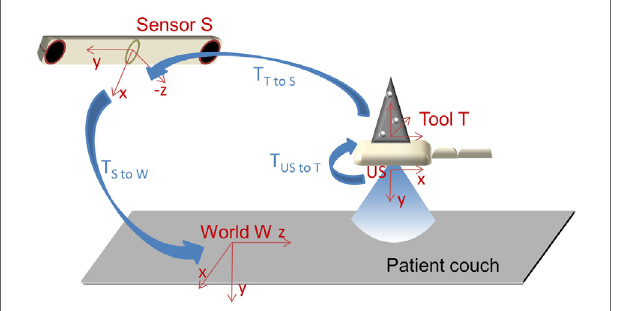
FigUre 1 | The four involved coordinate systems in ultrasound motion tracking: ultrasound image plane US ( z US = 0), optical marker tool T, optical sensor S as well as treatment room (“world”) W, and the transformations between